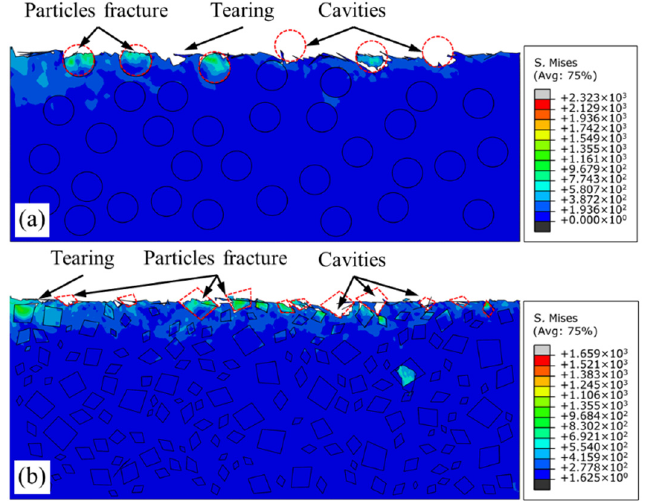
Figure 14. Simulated surface morphology under a cutting speed of 250 mm/s and a cutting depth of 25 μ m: ( a ) circular particles; ( b ) irregular polygonal particles.